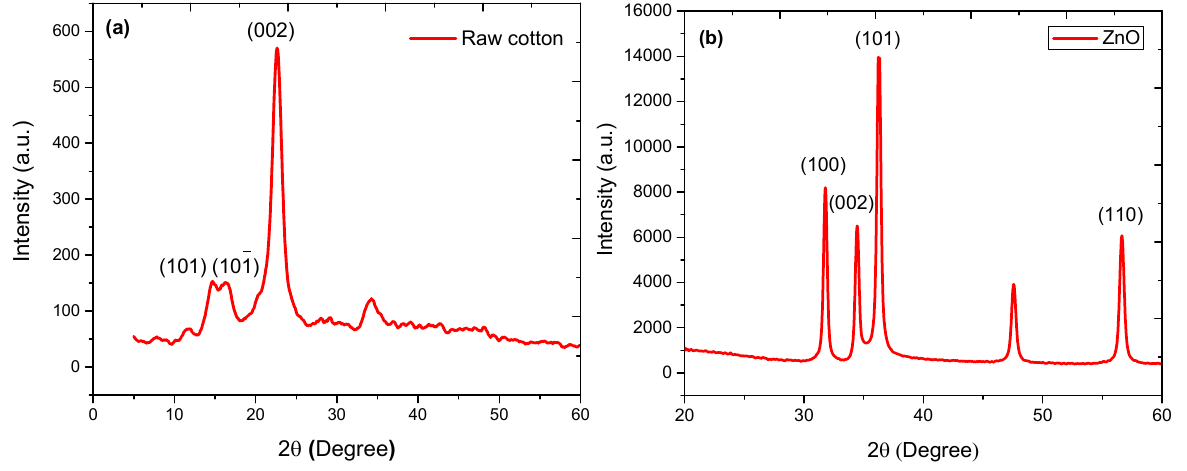
Figure 4. XRD spectra of ( a ) raw cotton and ( b ) as-produced ZnO nanoparticles before coating over cotton fabric.